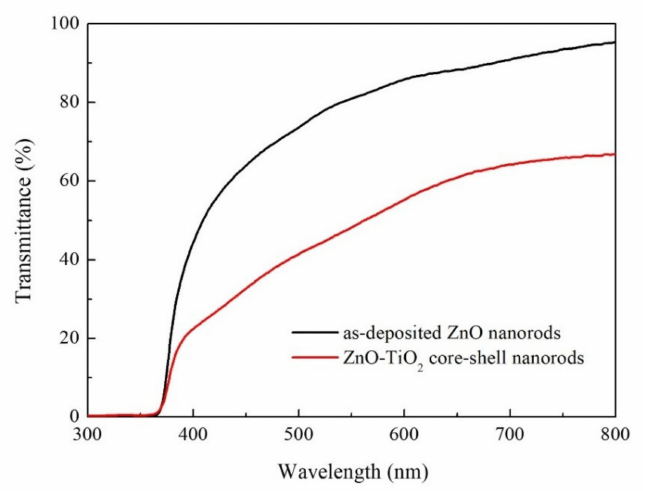
Figure5. Opticaltransmissionspectraofas-depositedZnOnanorodsandZnO–TiO 2 core–shellnanorods.